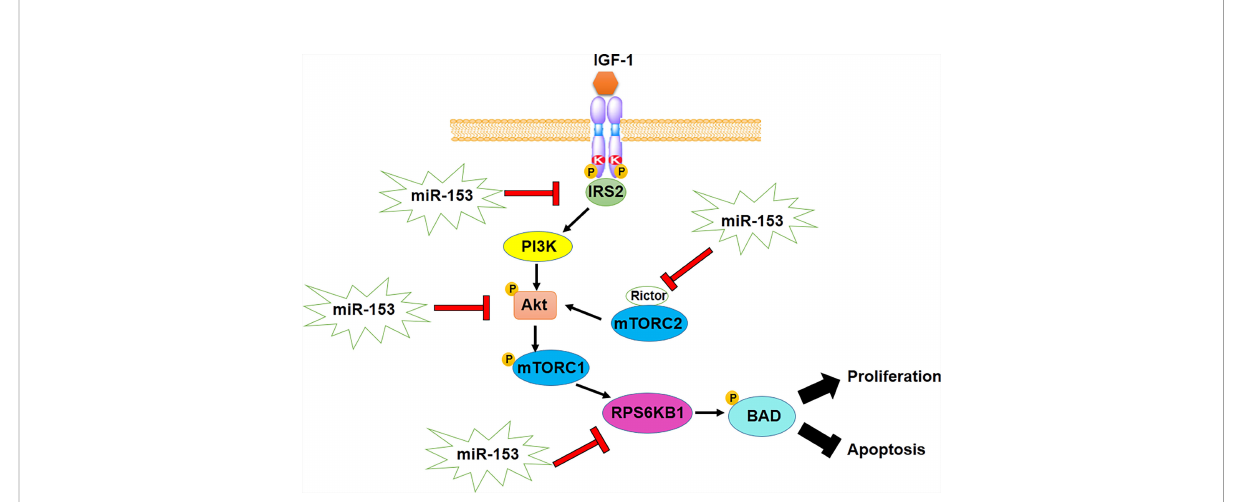
FIGURE 1 anti-proliferative activity of miR-153 by modulating IRS2/PI3K/AKT/mTOR